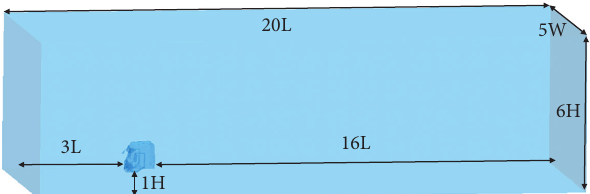
Figure 2: Computational domain around the commercial vehicle cab and its